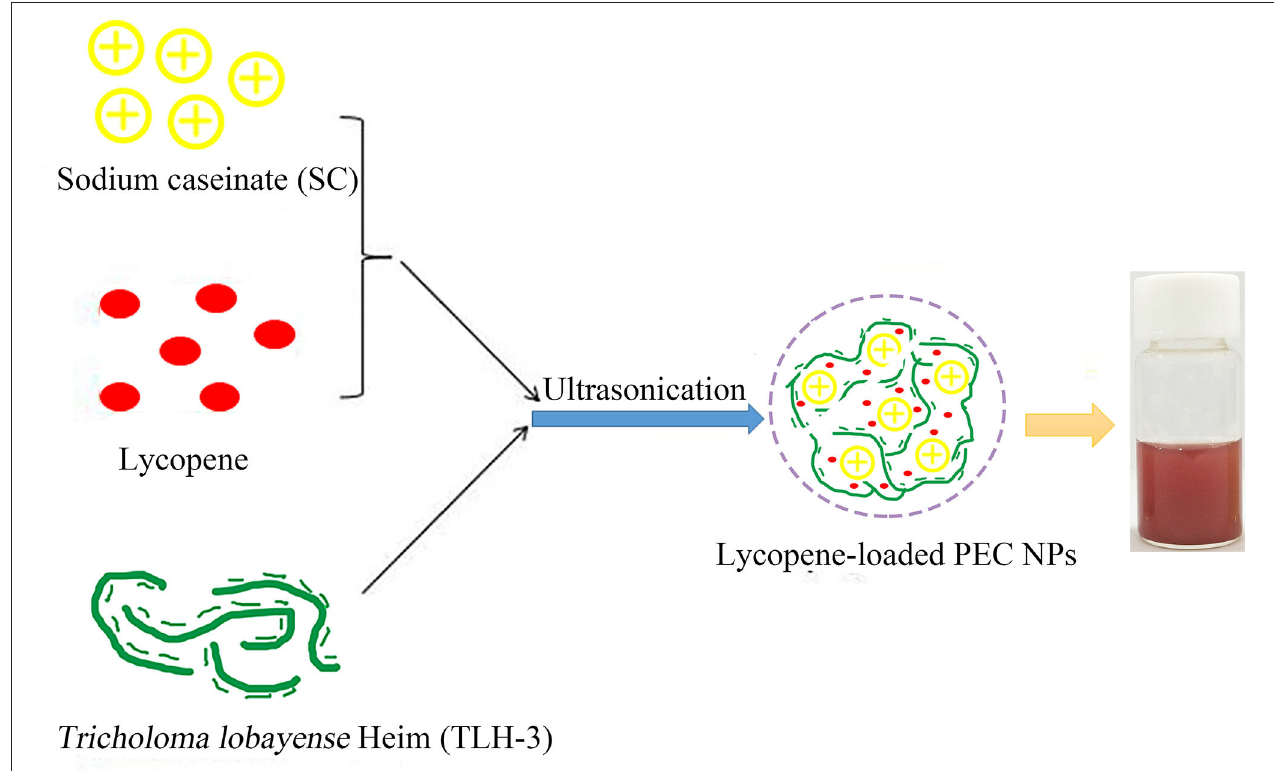
FIGURE 1 | The detailed schematic for the production of lycopene-loaded polyelectrolyte complex nanoparticles (PEC NPs).